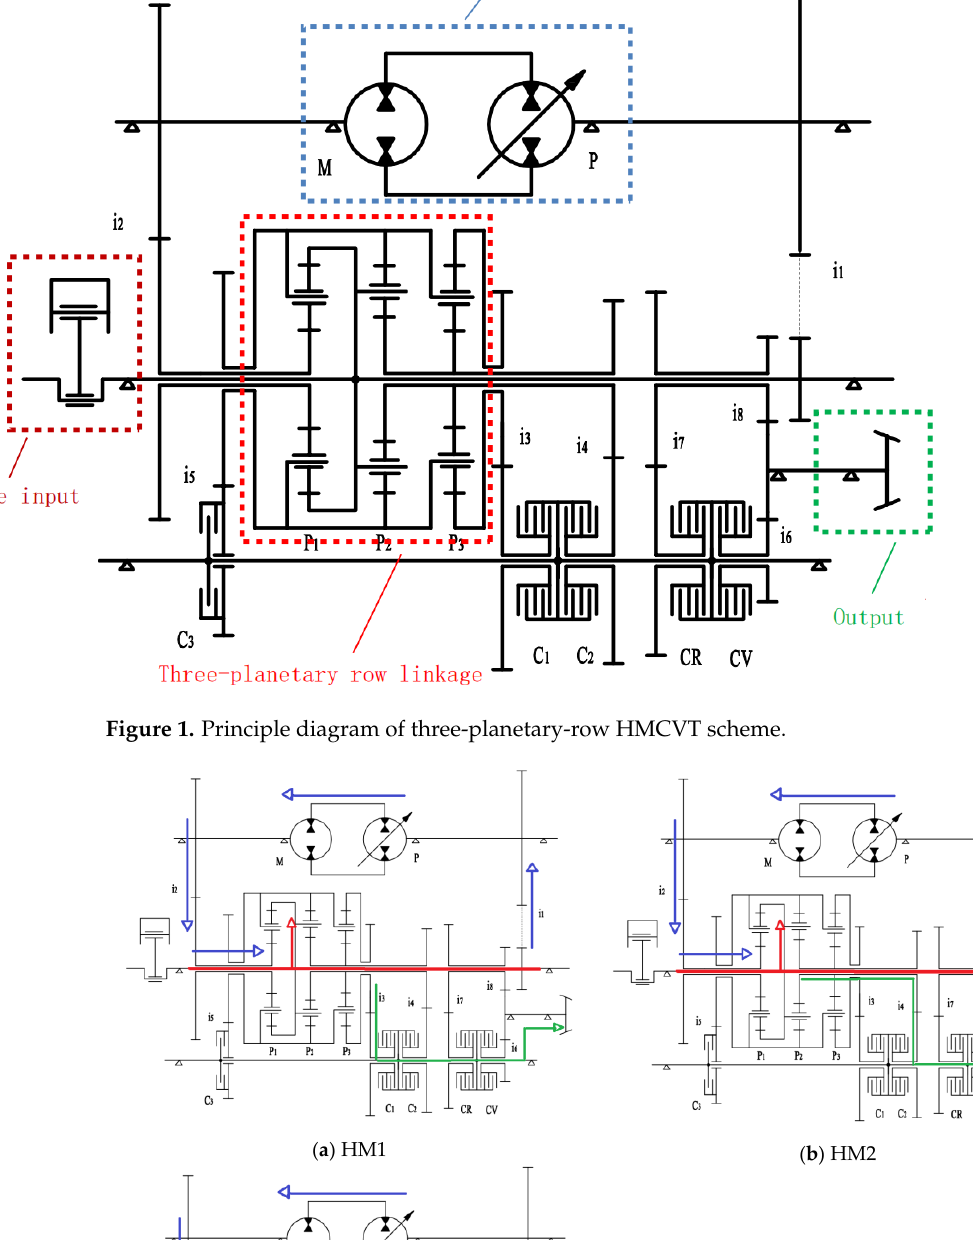
Table 1. Working states of clutches in different working sections.